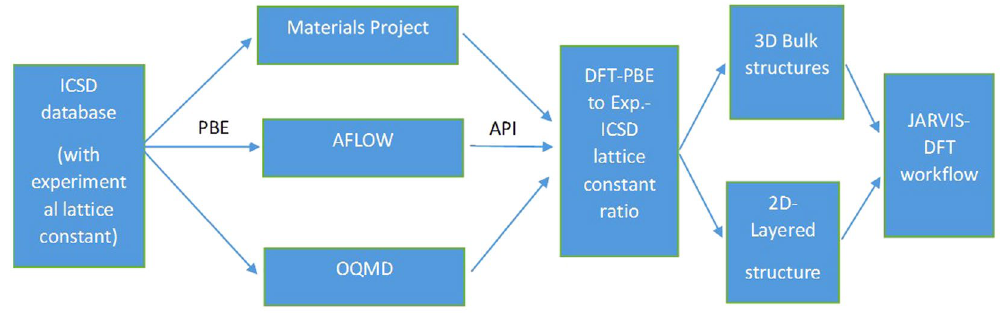
Figure 7. Illustration about initial screening of 2D materials is shown. DFT databases used ICSD crystallographic database to characterize bulk materials with PBE functional. PBE functional is known to overestimate lattice constant of materials which can be 2D. Based on API, materials with reasonably high PBE to Experimental lattice constant difference were screened from thousands of materials available in the DFT databases. Layered counterparts of these materials were made manually. Both bulk and layered materials were then subjected to a series of DFT calculations for their property